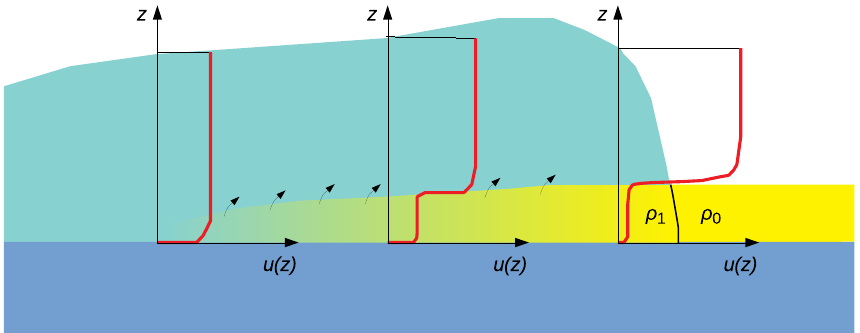
Figure 4. Schematic representation of the entrainment process for entire slabs. At the avalanche front, the new-snow layer (yellow, density ρ 0 ) is compressed to density ρ 1 , but only partially accelerated, as shown by the rightmost velocity profile. Friction from the overriding avalanche body (turquoise) reduces the velocity deficit of the slab (represented by color changing from yellow to turquoise) until it becomes a part of the main body. During the process, scouring entrainment may also occur (small